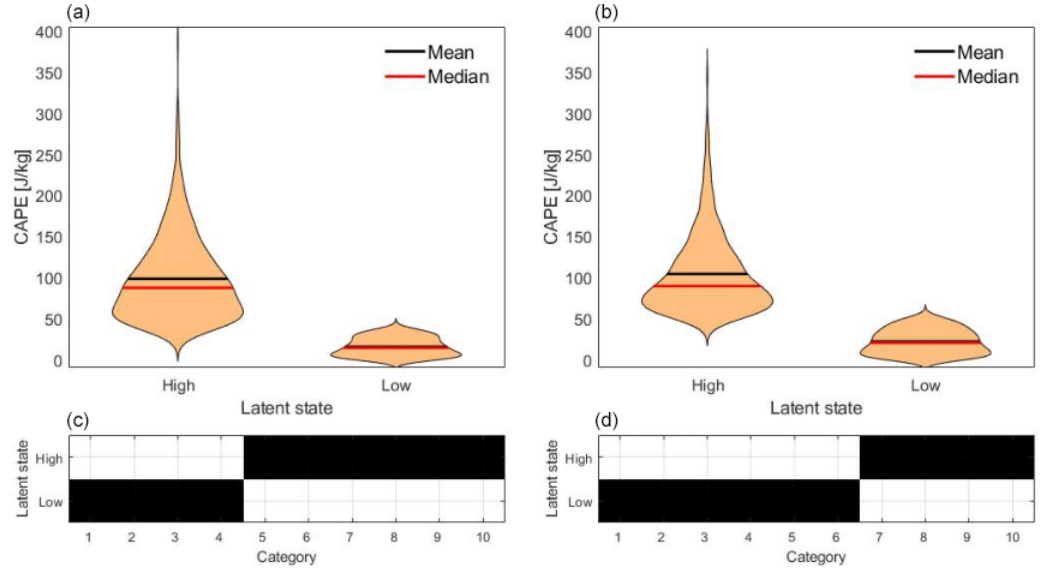
Figure 7. (a, b) Distributions based on kernel density estimation show the 12h averaged CAPE data which are affiliated to the high and low latent states. Panel (a) presents day data and panel (b) the night data. (c, d) Affiliation of CAPE categories to the latent states. CAPE data are spatially averaged over the northwest quadrant of the COSMO-REA6 data, and the vertical velocity is averaged for a box discretization of 4096 grid boxes; see Table